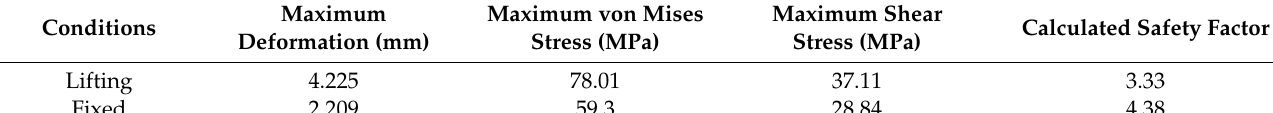
Table 4. FEM results for pressure hulls.